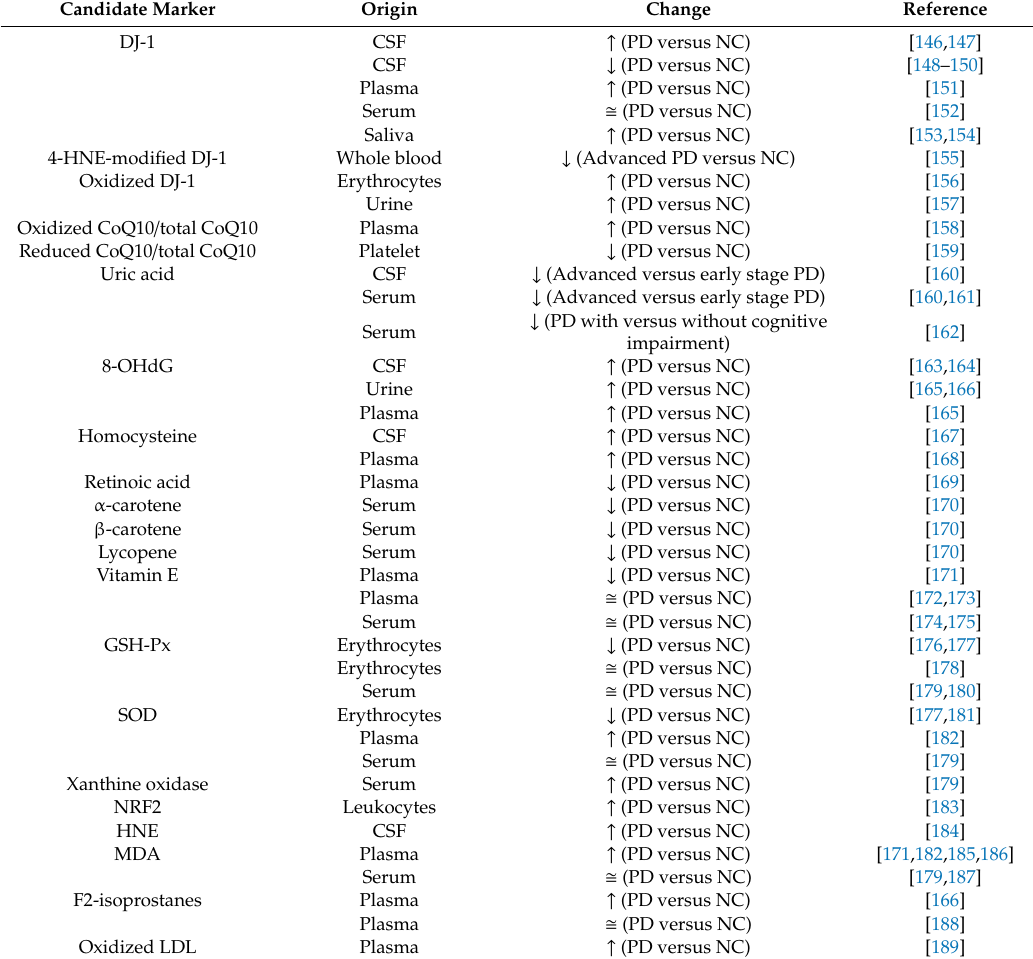
Table 1. Potential biomarkers involving oxidative stress for Parkinson’s